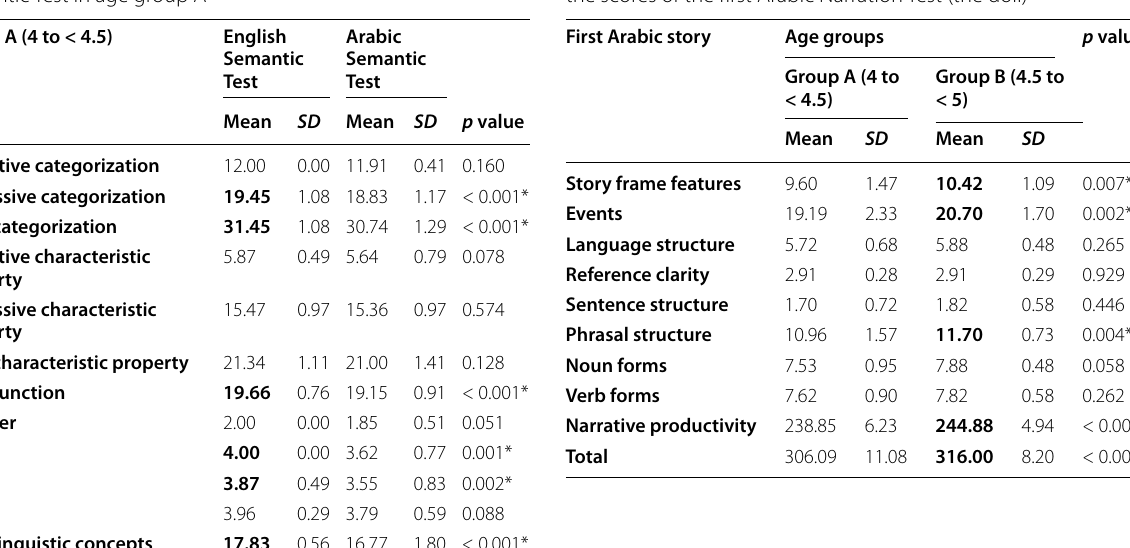
Table 6 Comparison between the two age groups regarding the scores of the first Arabic Narration Test (the doll)